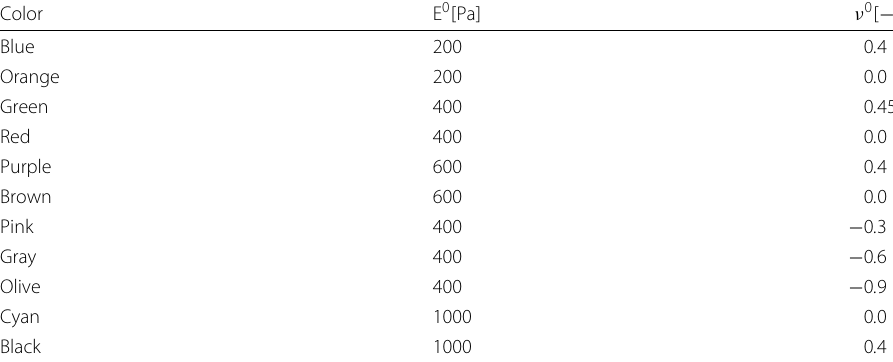
Table1 Initial guesses for different inverse analysis runs in homogeneous